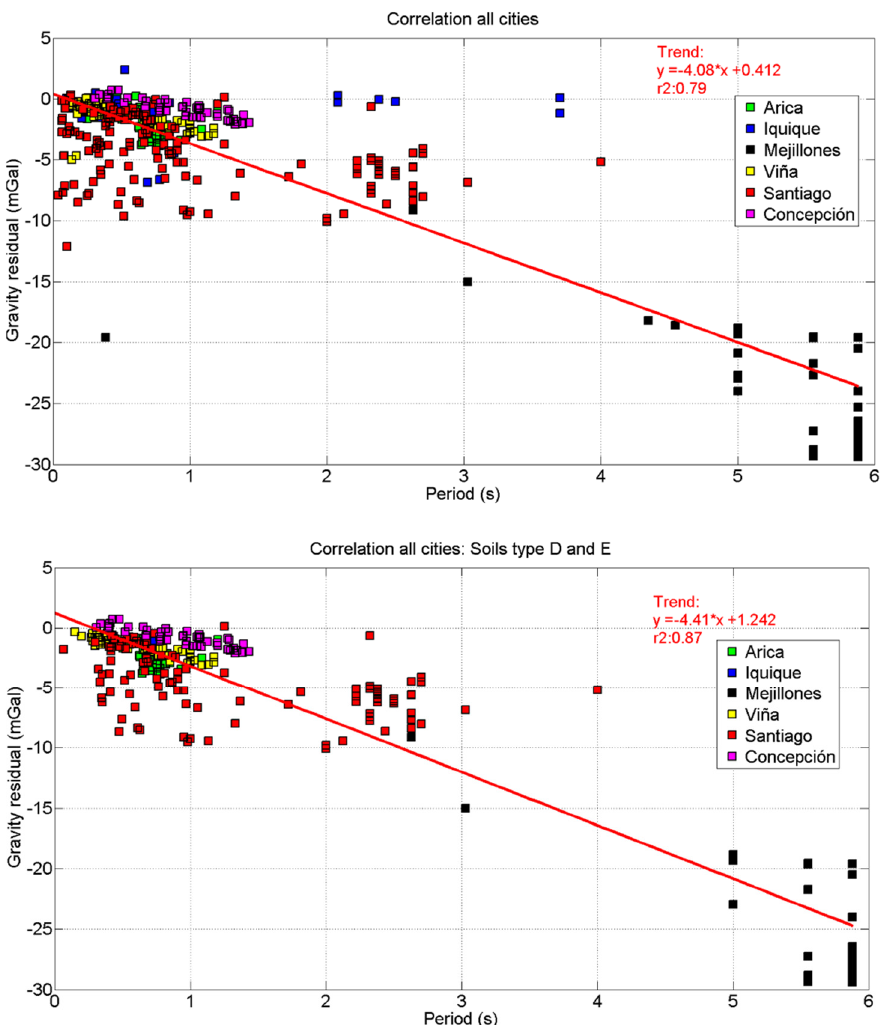
Figure 10. Correlation between gravity residuals and H/V predominant periods in the five cities studied in this research. Red line corresponds to the calculated linear regression. Upper panel shows the results for all the type of sites presented in the area according to the seismic classification in Table 1. The lower panel shows the same results only for soft sites with classification of D and E.